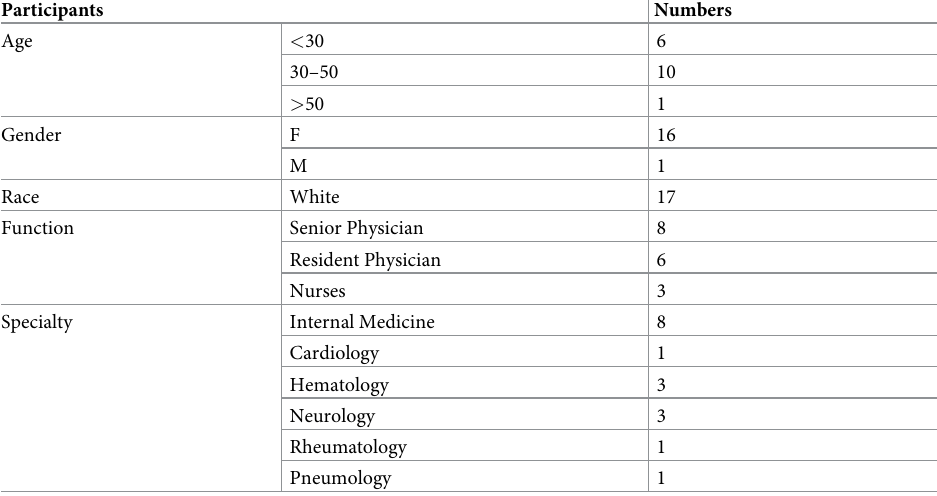
Table 2. Participants’